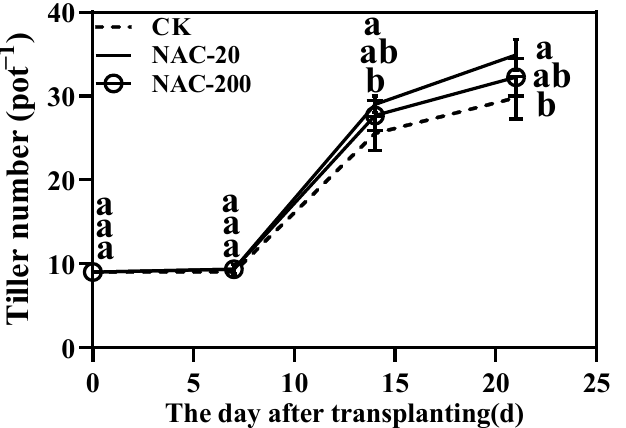
Figure 2. Effects of different concentrations of NAC on the tiller numbers within 3 weeks after trans- planting. CK, 0 μ m;NAC − 20, 20 μ m;NAC − 200, 200 μ m. Data are means ± SD ( n = 3). The different letters following average values indicate significant difference (Duncan, p < 0.05).